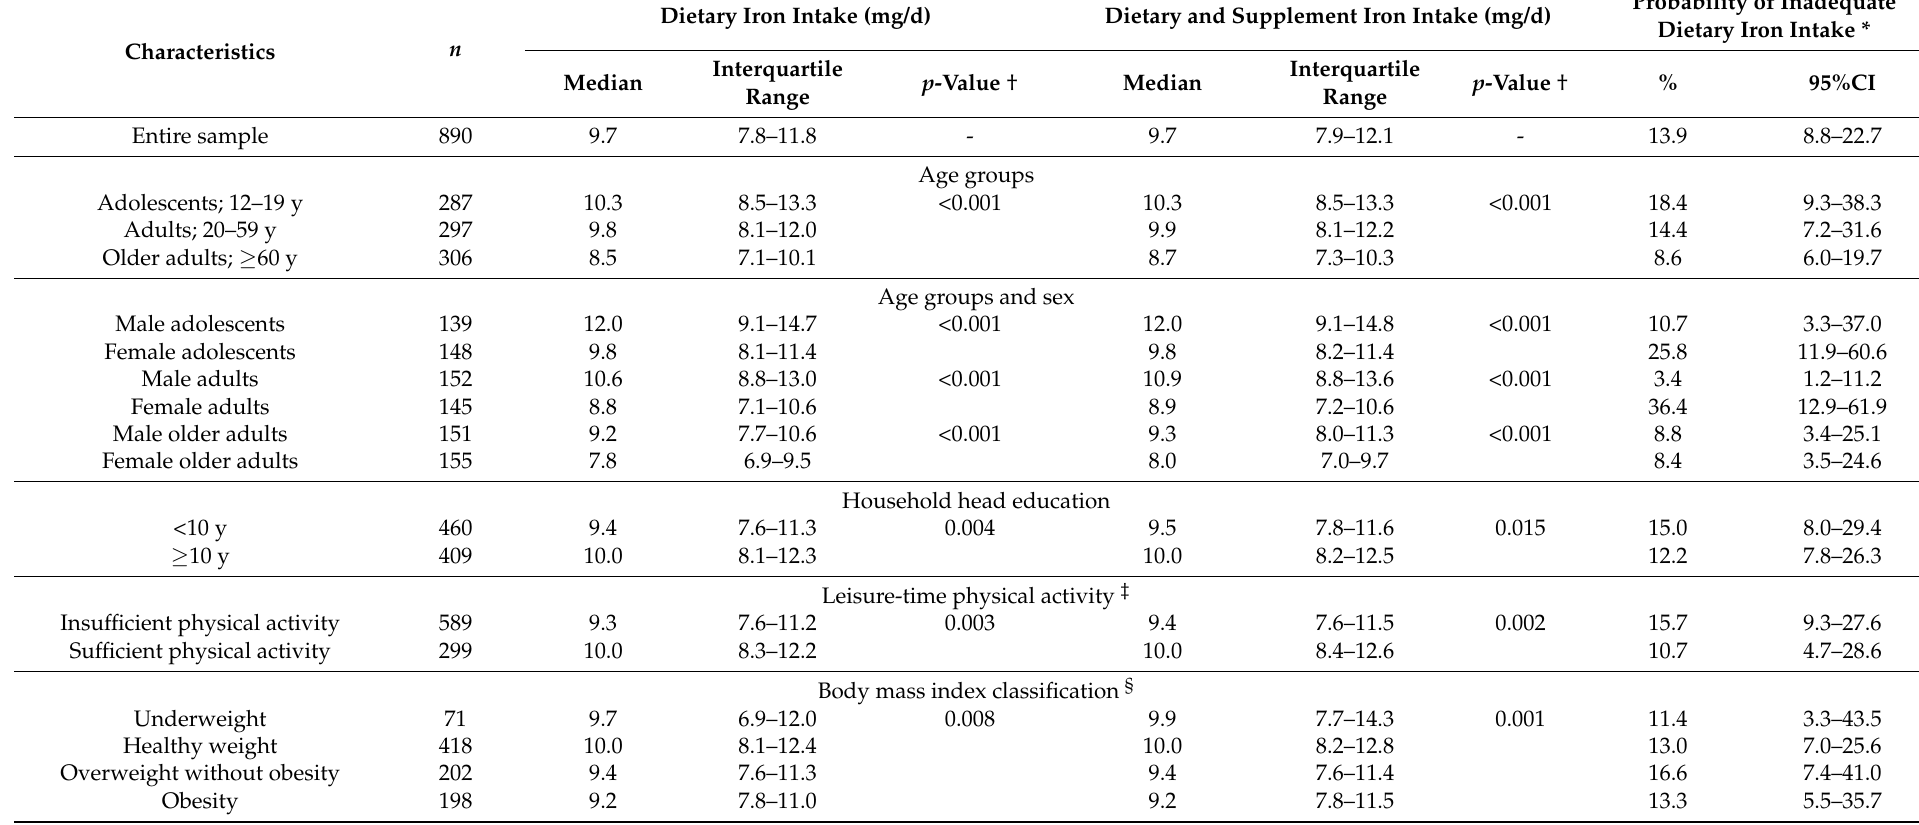
Table 3. Dietary and supplemental iron intake and the probability of inadequate dietary iron intake among residents of the urban area of S ã o Paulo, according to sociodemographic and lifestyle factors: 2015 Health Survey of S ã o